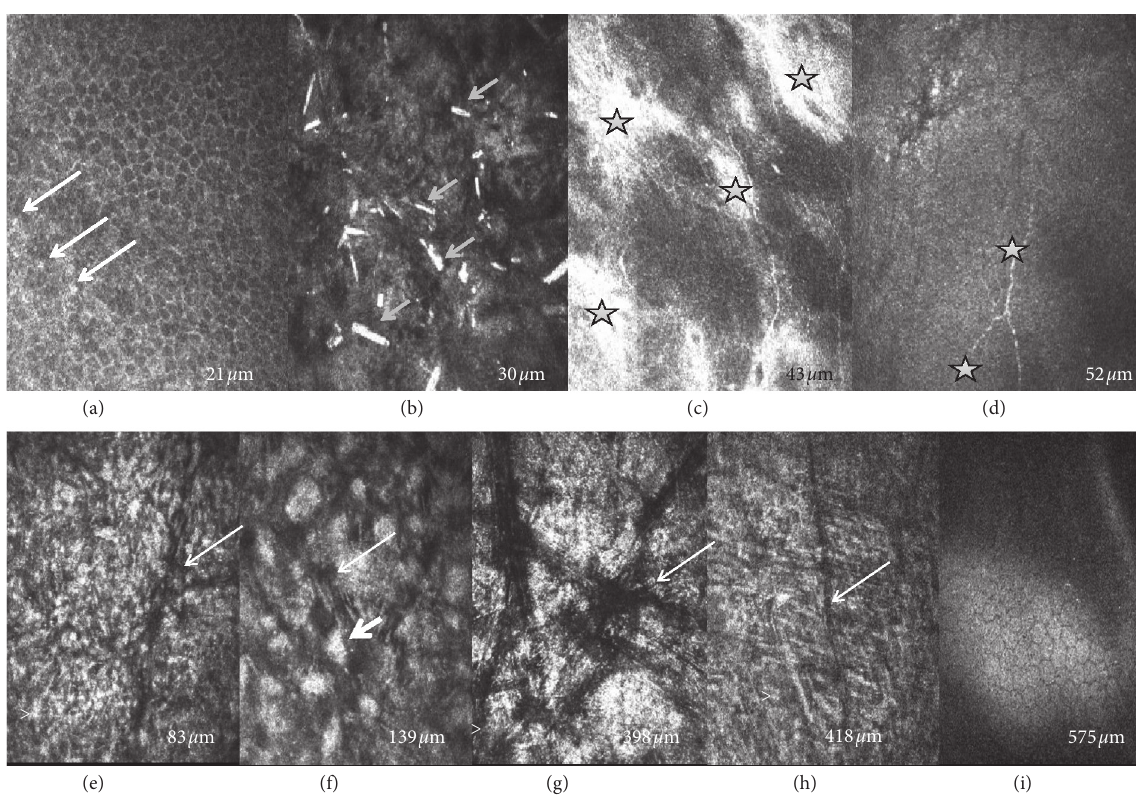
Figure 3: In vivo confocal microscopy images (400 × 400 μ m) at different scanning depths showing epithelial and stromal hyperreflective deposits and keratocyte damage in eyes with Schnyder dystrophy. (a) Epithelial wing cell layer with small round hyperreflective deposits (long thick arrows). (b) Basal epithelial cell layer with rod-shaped hyperreflective deposits (short arrows). (c) Both Bowman layer and the epithelial basement membrane (stars) appear to be undulated. (d) Thin subbasal nerves (stars). (e–h) stromal images show needle-shaped hyperreflective deposits (arrowheads), increased background reflectivity, stromal striae (thin arrows), absence of visible keratocyte nuclei, and rectangular deposits (thick arrow, only observed in patient #6). (i) Normal